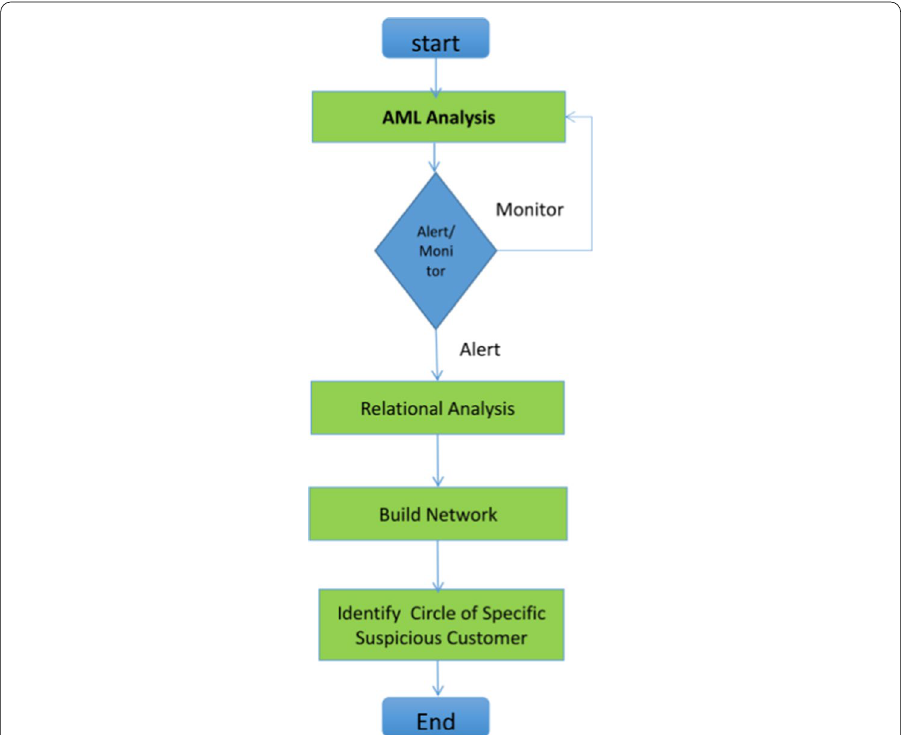
Fig. 2 Flow chart of the proposed